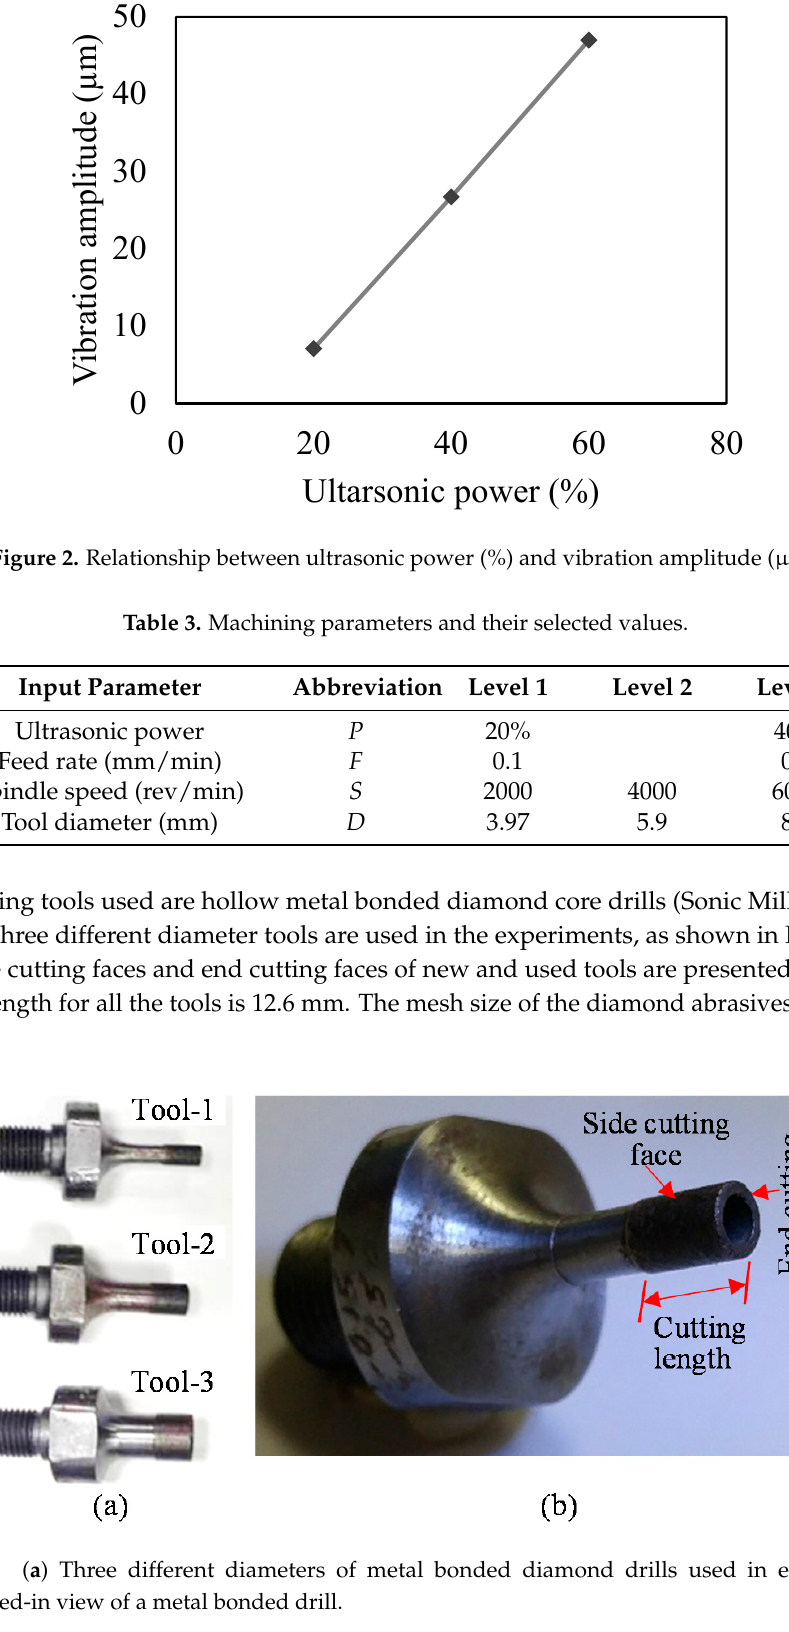
Figure 4. ( a ) Zoomed-in view of the side cutting face of a typical new drill; ( b ) Zoomed-in view of the side cutting face of a drill after machining; ( c ) Zoomed-in view of the end cutting face of a typical new drill; ( d ) Zoomed-in view of the end cutting face of a drill after machining.